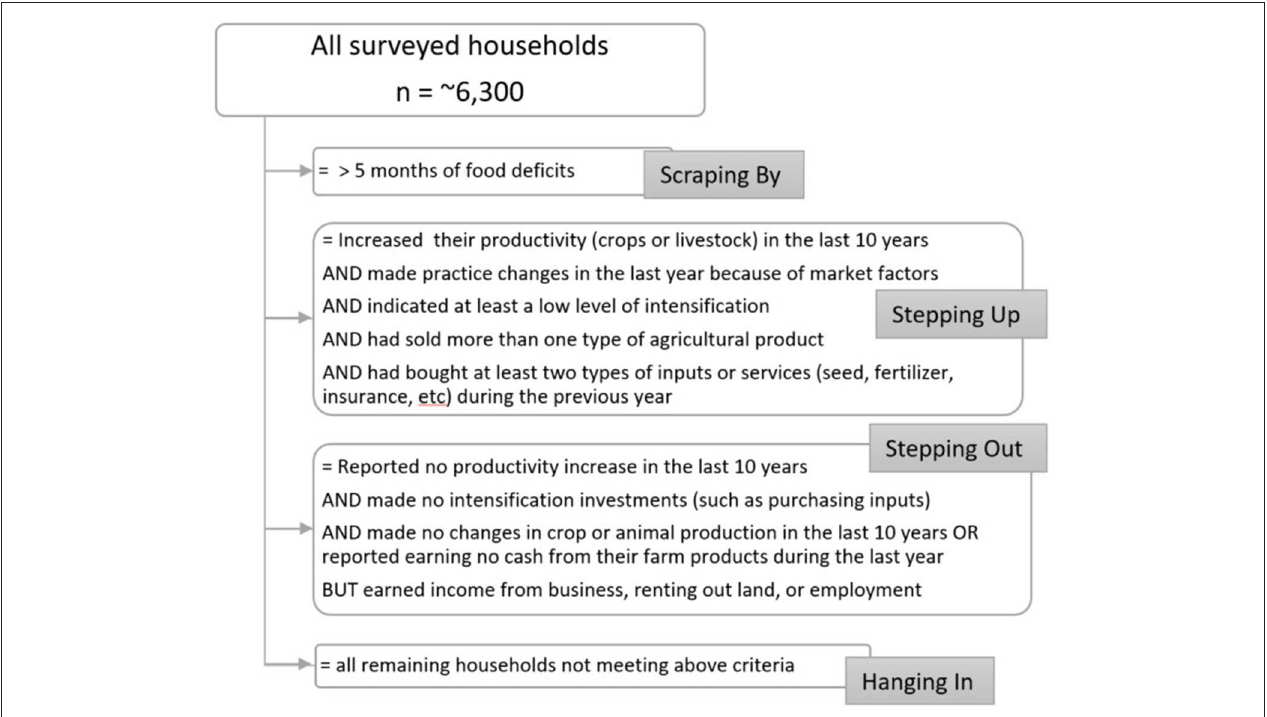
FIGURE 3 | Classification scheme used to determine typology of households in CCAFS study sites (Thornton et al.,